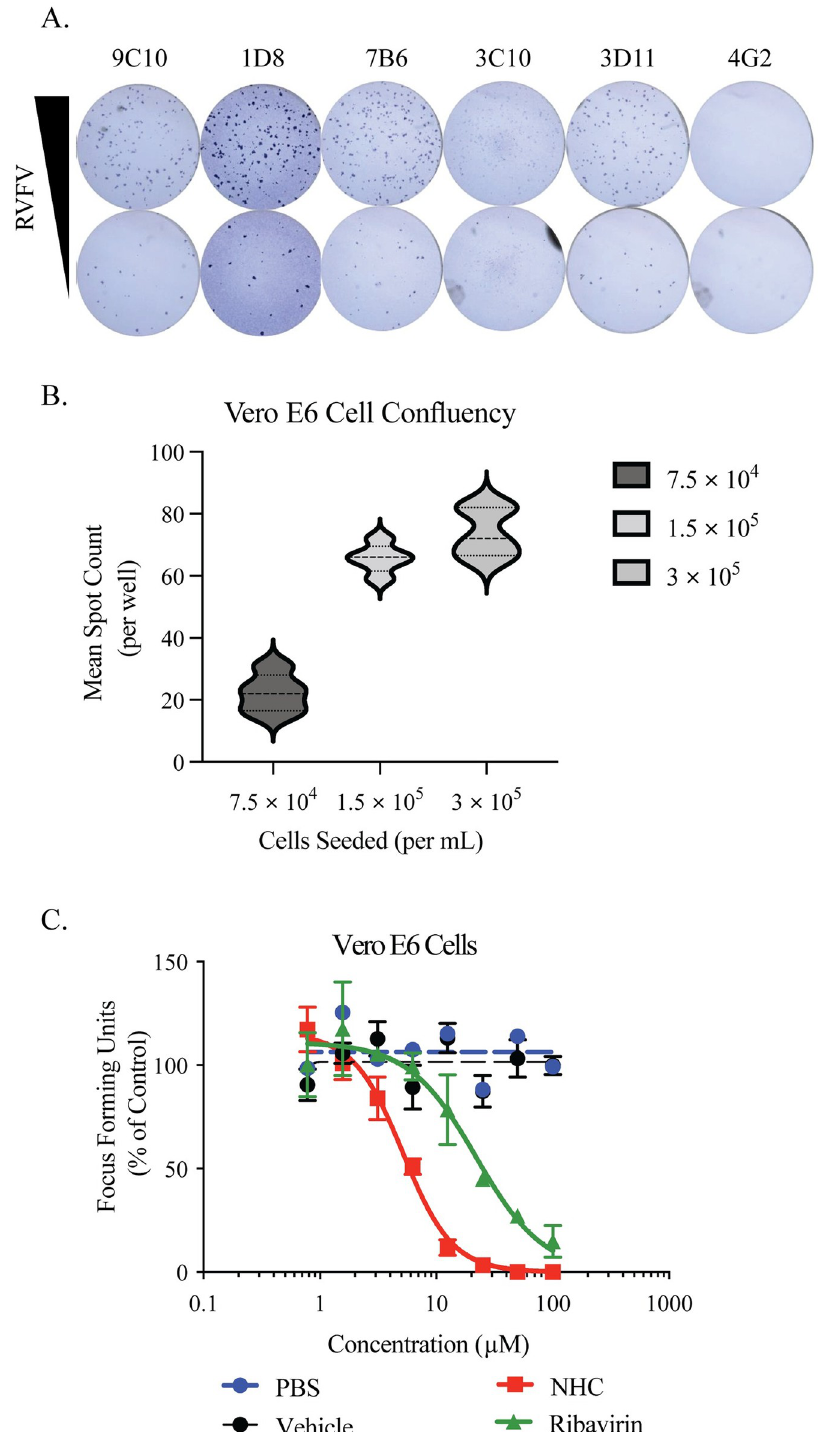
Fig 1. Development and validation of RVFV antiviral screen. A . Identification of optimal mAb for the detection of RVFV by mAb staining of a serial dilution of RVFV strain MP-12 in an FFA. B . Impact of cell number on the sensitivity of antiviral compound screen. C . Evaluation of the sensitivity of the antiviral compound screen based upon the evaluation of ribavirin and β -D-N4-Hydroxycytidine N4-Hydroxycytidine (NHC/EIDD-1931), a known antiviral for RVFV. Data is presented as focus forming units. These data are the cumulation of three independent experiments with technical duplicates.